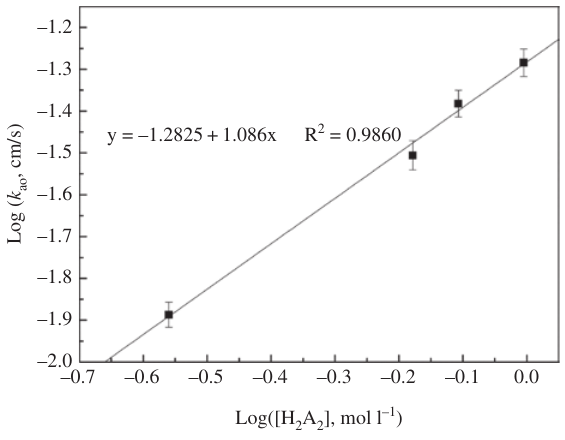
Figure 6: Effect of extractant concentration on extraction rate.